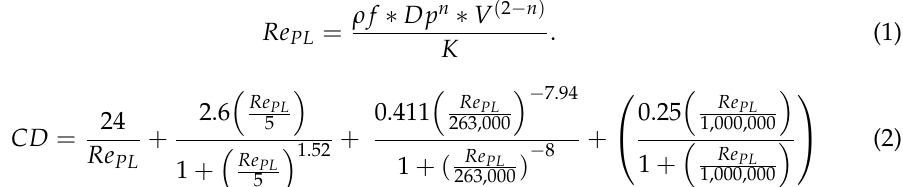
Figure 9. Terminal spherical particle settling in the unconfined model: ( a ) HVFR concentrations and ( b ) particle sizes impact.